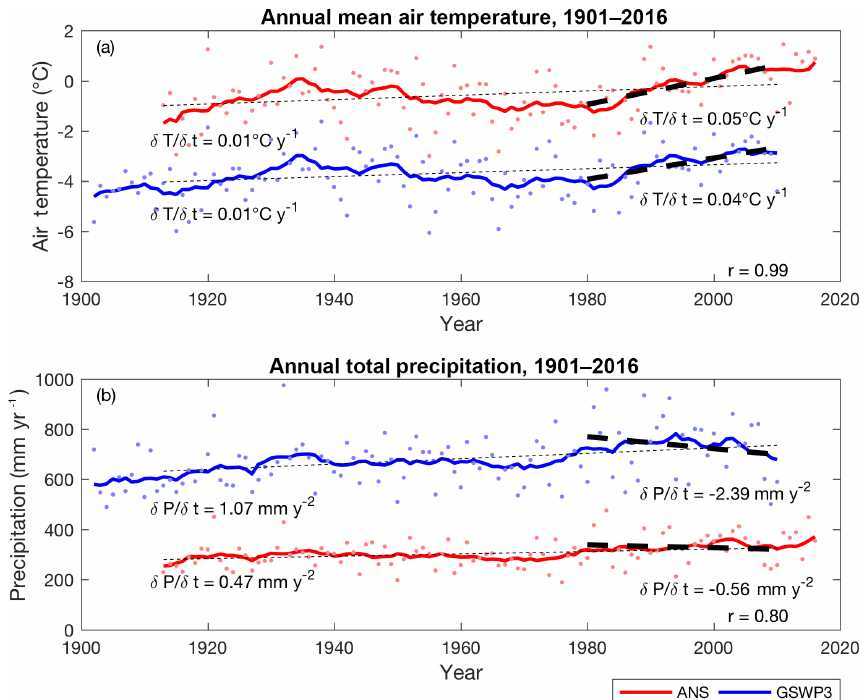
Figure 2. Time series of air temperature (a) and precipitation (b) measured at ANS (red; years 1913–2016) and extracted from GSWP3 (blue; years 1901–2010). Dots are the annual means, and solid lines are the decadal moving averages of the corresponding annual means. Thin and thick dashed lines are the trends for the years 1913–2010 and the years 1980–2010, respectively. The inset r values are the correlation coefficients calculated between the two time series.